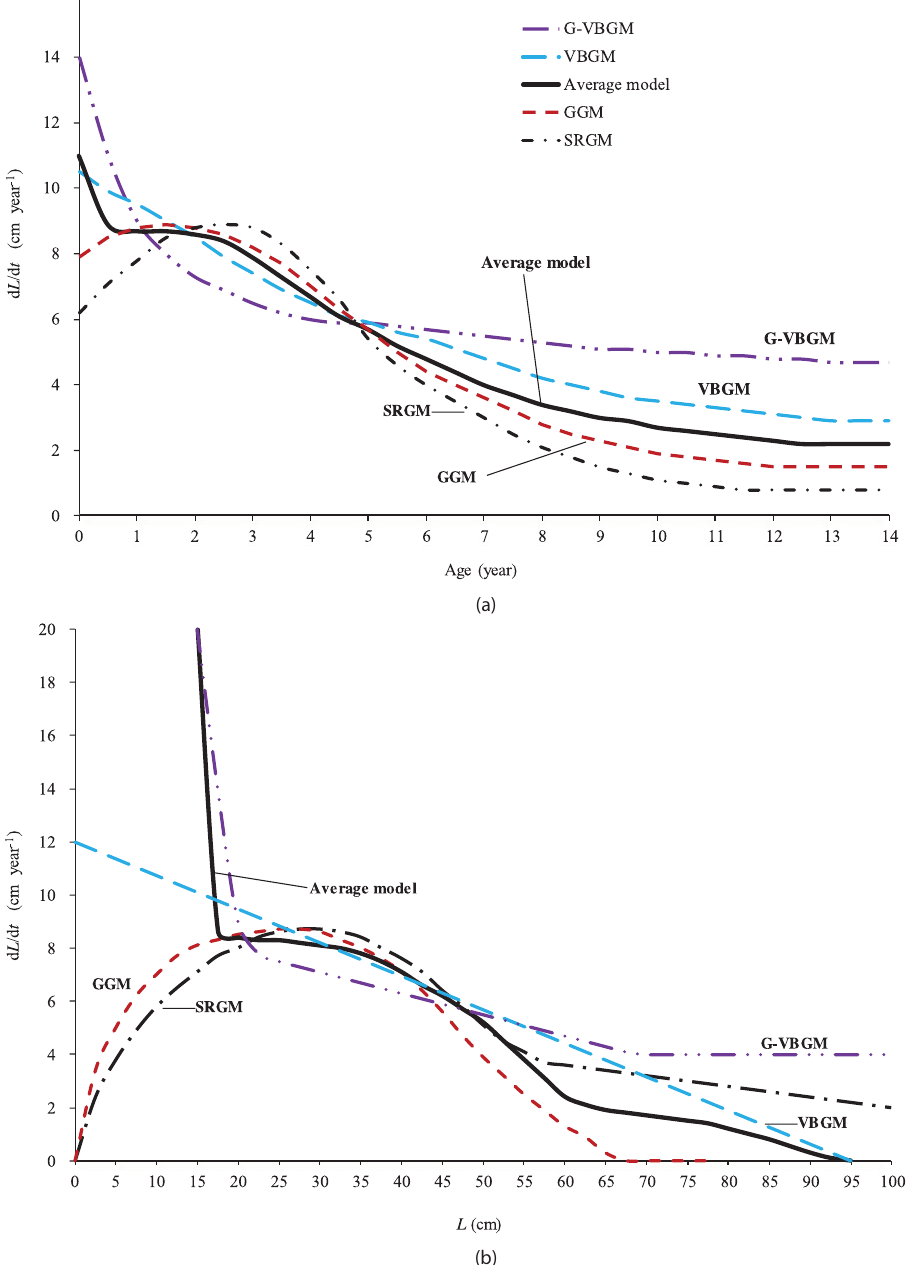
Fig. 4. The length at age data (dots) of the fi ve fi sh species and the fi tted curves for the four growth models (G-VBGM, SRGM, GGM and VBGM) used in this